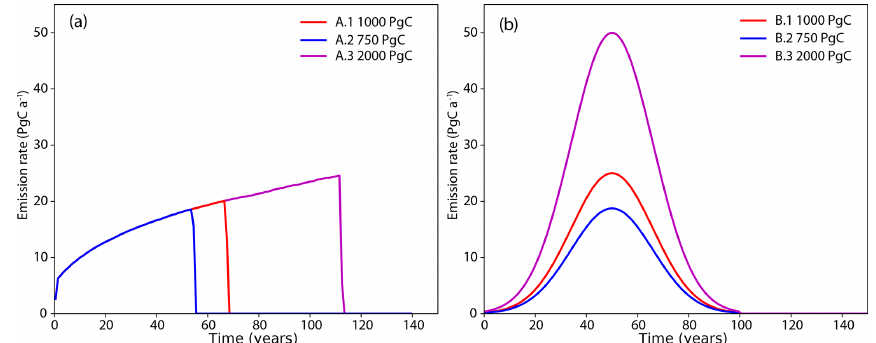
Figure 1. (a) Example of diagnosed emission from the UVic ESCM for the type A experiments. Emissions are diagnosed from the 1pctCO2 experiment, which has prescribed atmospheric CO 2 concentrations. The target cumulative emissions total is reached part way through the final year of emissions, thus the final year has a lower average emission rate than the previous year. (b) Time series of global CO 2 emissions for bell curve pathways B1 to B3. The numbers in the legend indicate the cumulative amount of CO 2 emissions for each simulation.